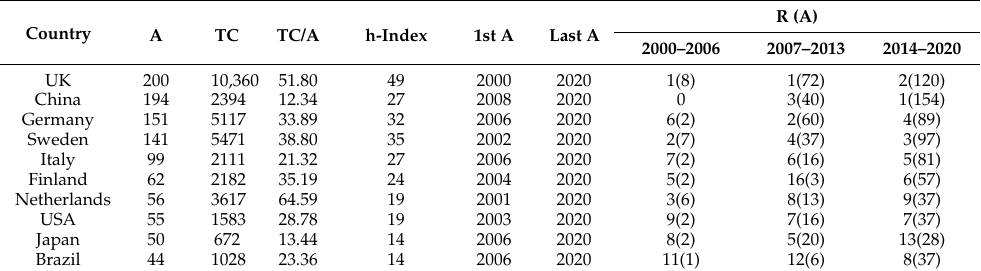
Table 5. The most relevant countries in number of